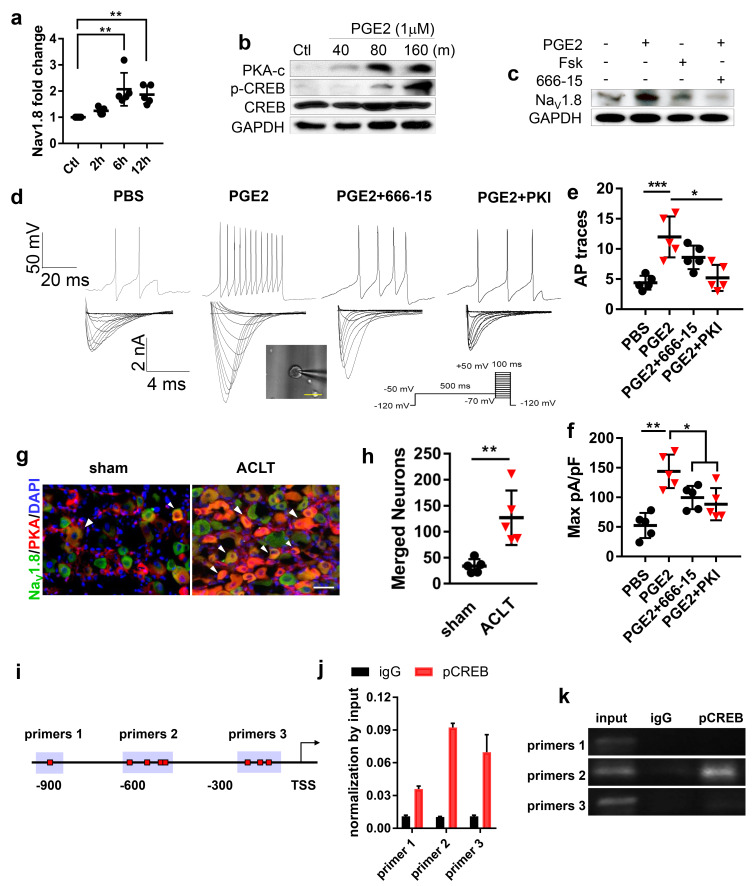
PGE2 upregulates NaV1.8 through PKA signaling.(a) RT-QPCR analysis of Nav1.8 in cultured lumbar DRG neurons treated with PGE2 (1 μM) for 2–12 hr. n = 6 per group. (b) Representative of western blots of PKA-c, CREB and p-CREB in cultured lumbar DRG neurons treated with PGE2 (1 μM) for 40–160 min. (c) Representative of western blots of the Nav1.8 in cultured lumbar DRG neurons treated with PGE2 (1 μM), forskolin (10 μM), or 666–15 (1 μM) for 6 hr. Representative traces of action potentials (d, upper) and Nav1.8 currents (d, lower) and statistical analysis of maximal Nav1.8 current density (f) of cultured lumbar DRG neurons after sham or ACLT surgery at 1 m. n = 6 per group. (e, f) Co-immunostaining of NeuN and Nav1.8 (g) and statistical analysis of merged cell numbers (h) in ipsilateral L4 DRGs after sham or ACLT surgery at 1 m. n = 6 per group.(i–k) ChIP experiment showing putative primers (i), PCR (j) and gel running results (k) of NaV1.8 promoter, the experiments were repeated three times. n.s, non significant, *p<0.05, **p<0.01, ***p<0.001, ****p<0.0001 compared with the sham-operated group at different time points. Statistical significance was determined by multifactorial ANOVA WITH BONFERRONI POST HOC TEST (a, e and f), unpaired Student’s t test (h), all data are shown as scattered plots with means ± standard deviations.Figure 4—source data 1.Raw data of Navs QPCR, subchondral Nav1.8 fiber density, Retrograde tracing, Von Frey tests, GcAMP3 imaging, and electrophysiological recordings.Figure 4—source data 2.Full scan of western blots in Figure 4b.Figure 4—source data 3.Full scan of western blots in Figure 4c.Figure 4—source data 4.Full scan of western blots in Figure 4k.